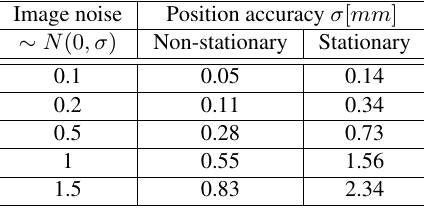
Table 5. Estimated position accuracy measures as a function of the noise